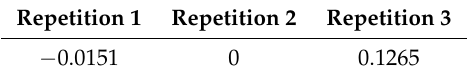
Table A2. kNN features predictive weight ( Importance Mean ) obtained through permutation feature importance.